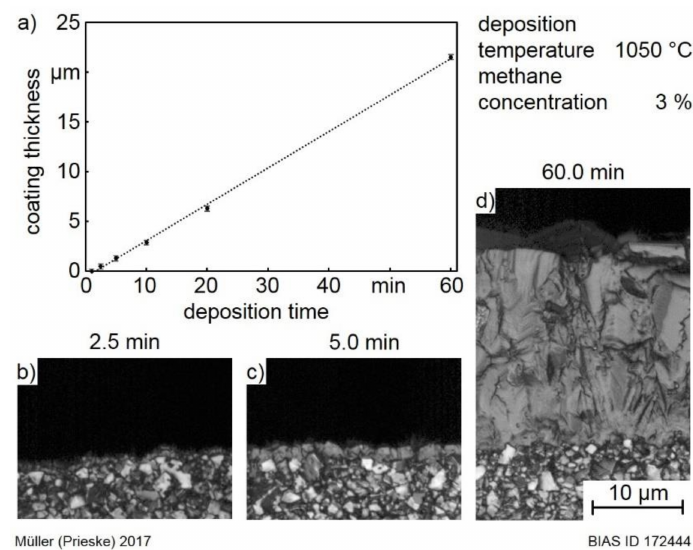
Figure 8. ( a ) The trend of the growth rate for di ff erent deposition times at the temperature of 1050 ◦ C and the methane concentration of 3% and cryofractures of the coatings after the deposition times of ( b ) 2.5 min, ( c ) 5 min and ( d ) 60